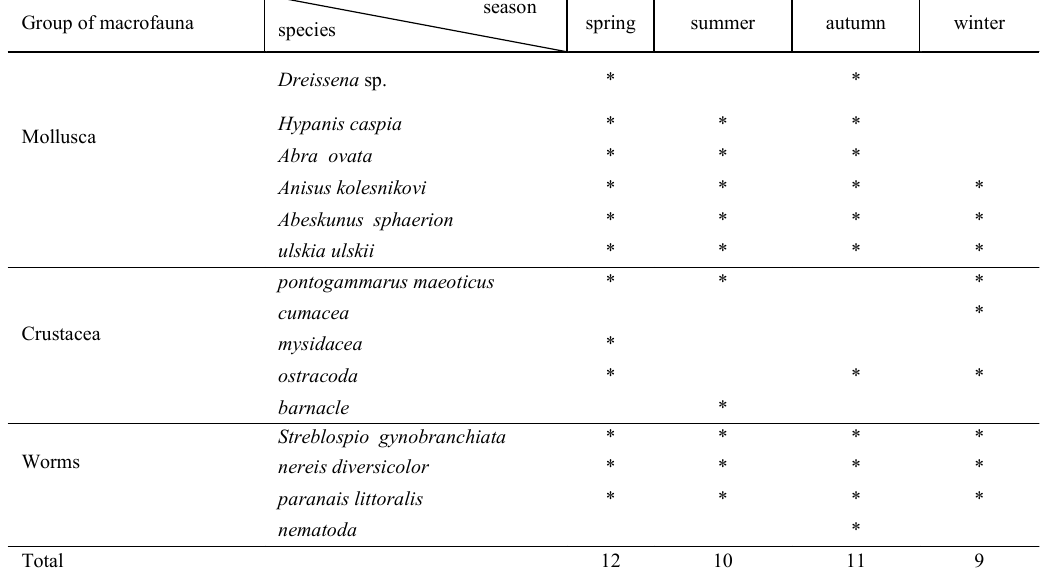
Table 12: Living identified species of macrofauna in the southern Caspian Sea from Behshahr to Ramsar in different seasonss. season Group of macrofauna species spring summer autumn winter Dreissena sp. Mollusca